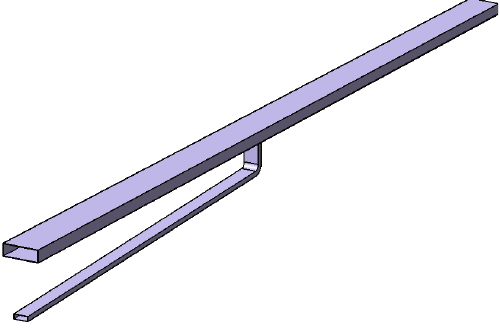
Figure 8: Beam model of the SBW. Table 3: Design parameters of the beam model.